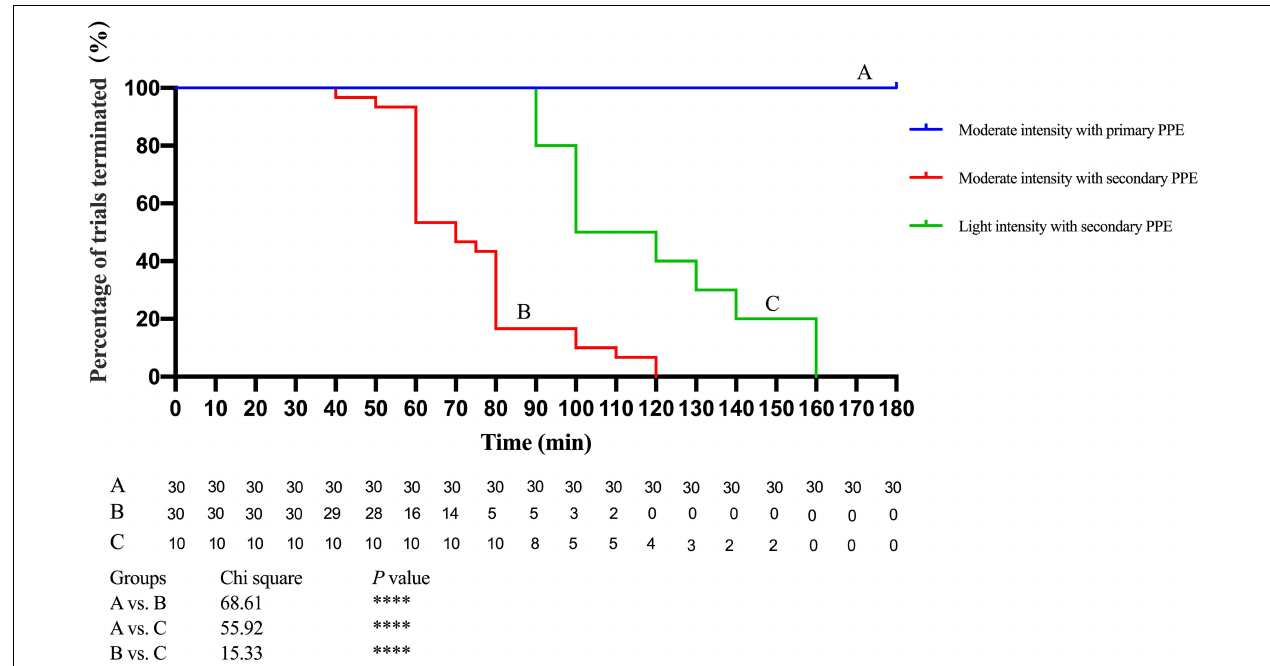
FIGURE 1 | Analysis of trail duration of participants with secondary personal protective equipment (PPE) and moderate-intensity with secondary or primary PPE. ∗∗∗∗ p < 0.0001. The p values were calculated using the Log-rank test. PPE, personal protective equipment.